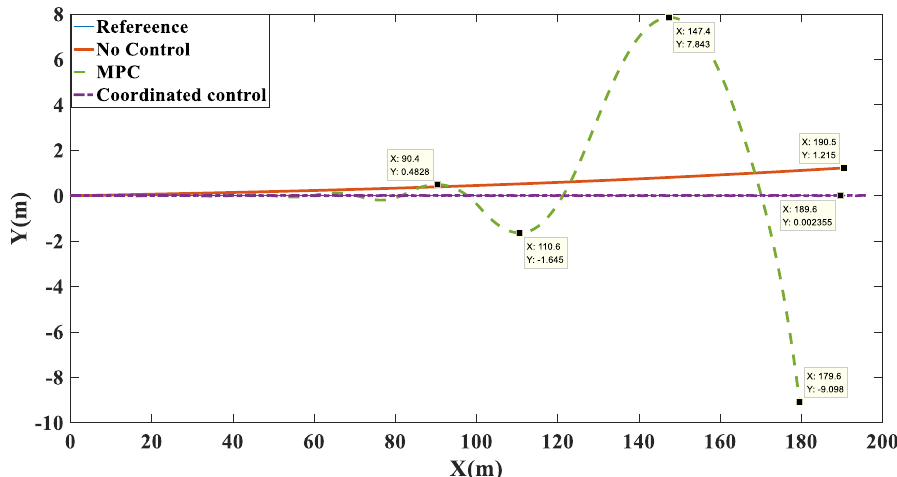
Figure 9. Path tracking comparison chart on the split mu straight road.